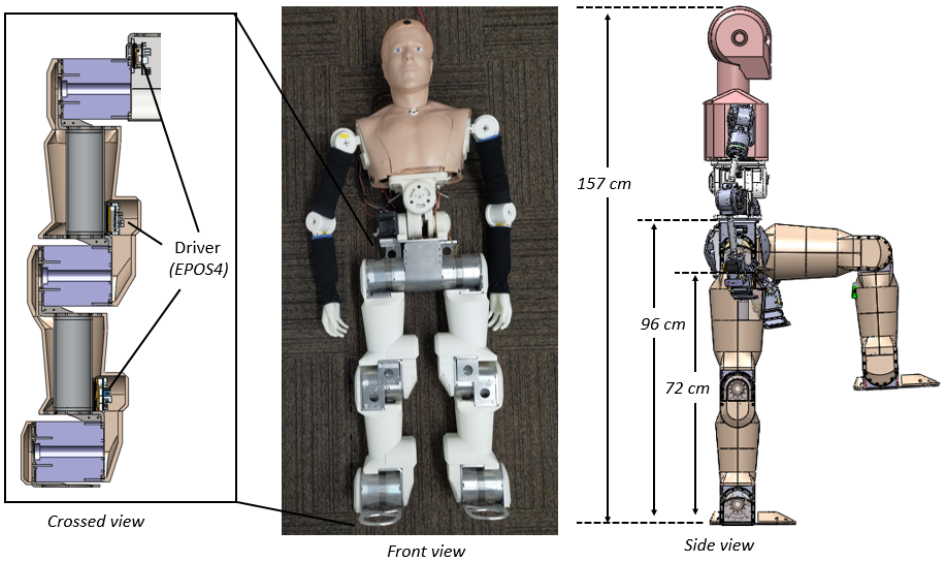
Figure 3. Configuration of improved robot patient with active joints in lower limbs.